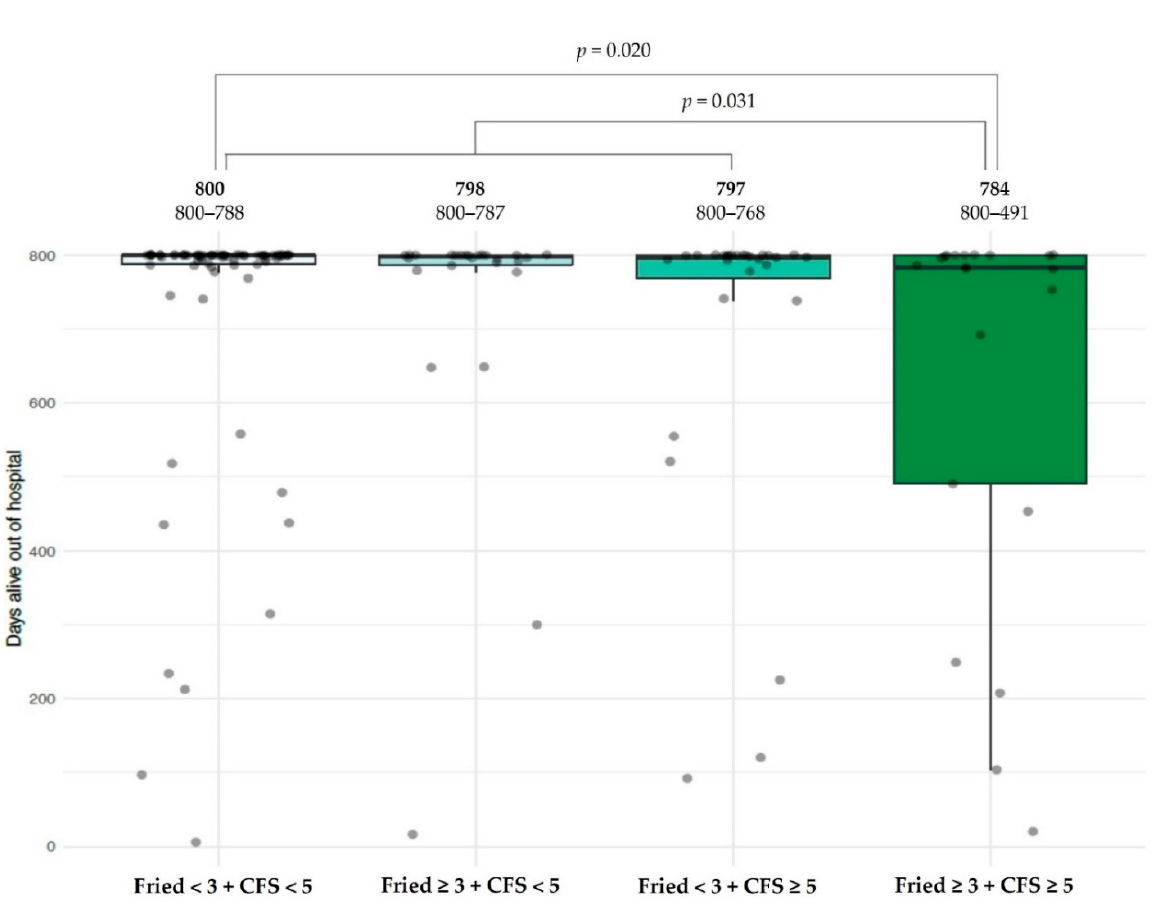
Table 3. Multivariate Cox regression. Impact of FFS and CFS on endpoints at follow-up. FFS (Points)